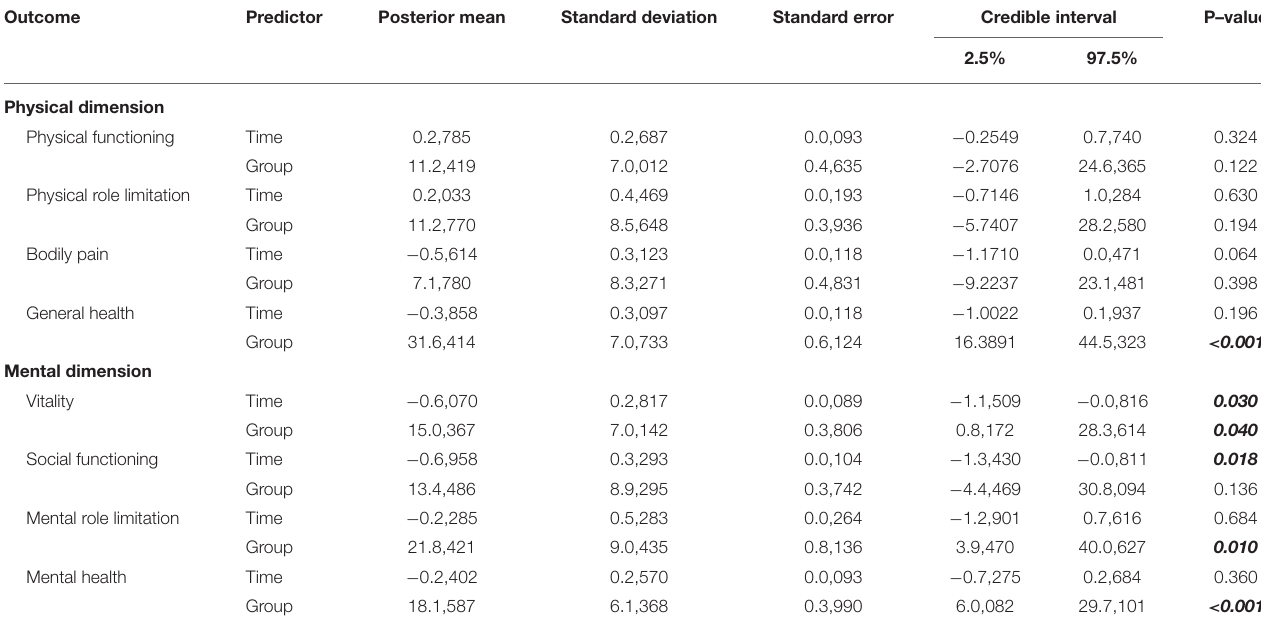
TABLE 3 | Effectiveness of family–centered empowerment model (FCEM) using the Bayesian multivariate mixed–effects model in different quality of life subscales.